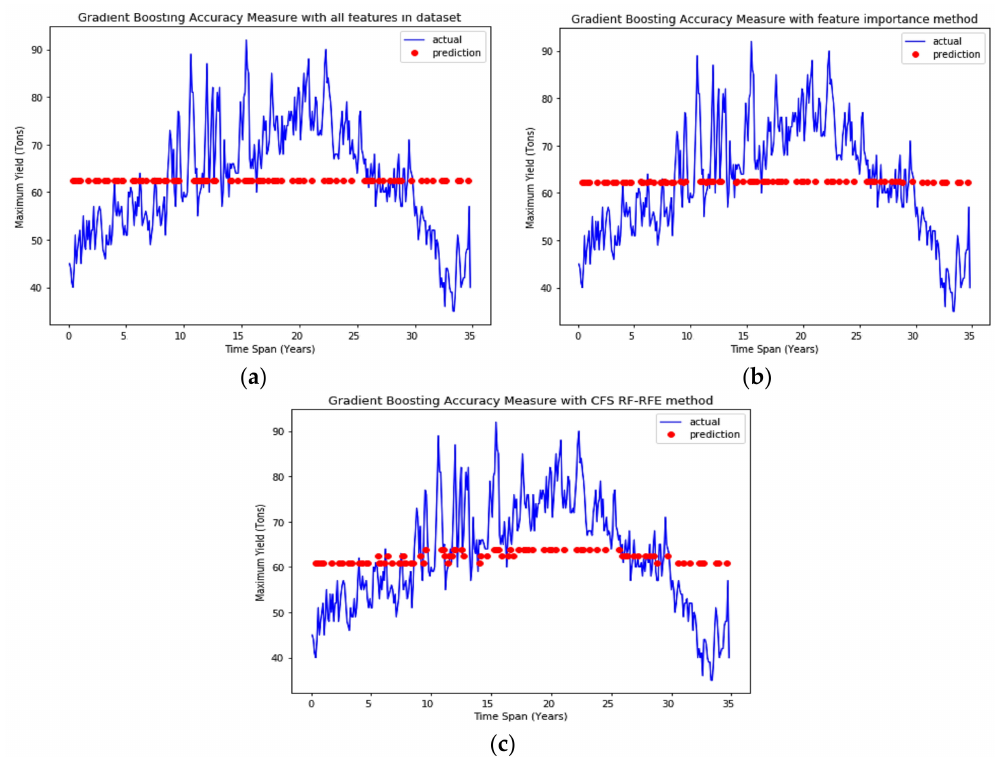
Figure 5. Gradient boosting model accuracy measure using: ( a ) proposed CFS RF-RFE feature selection method, ( b ) algorithm in-built feature importance method, ( c ) all the features in the dataset.